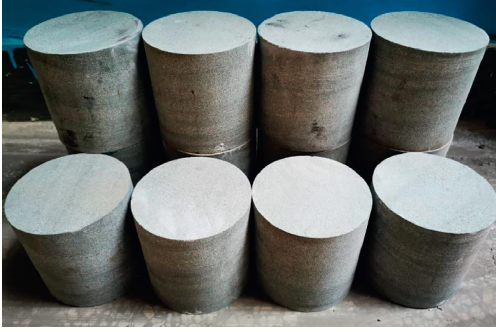
Figure 1: Sandstone samples for impact tests. Table 1: Static physical mechanics parameters of sandstone.